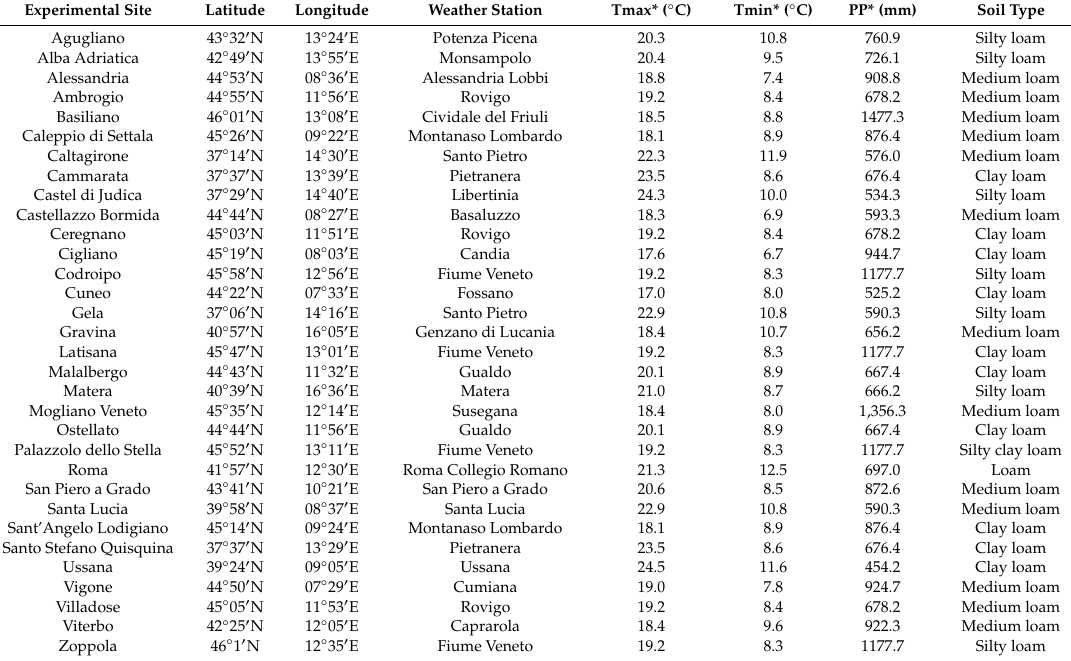
Table 3. Characterization of the experimental